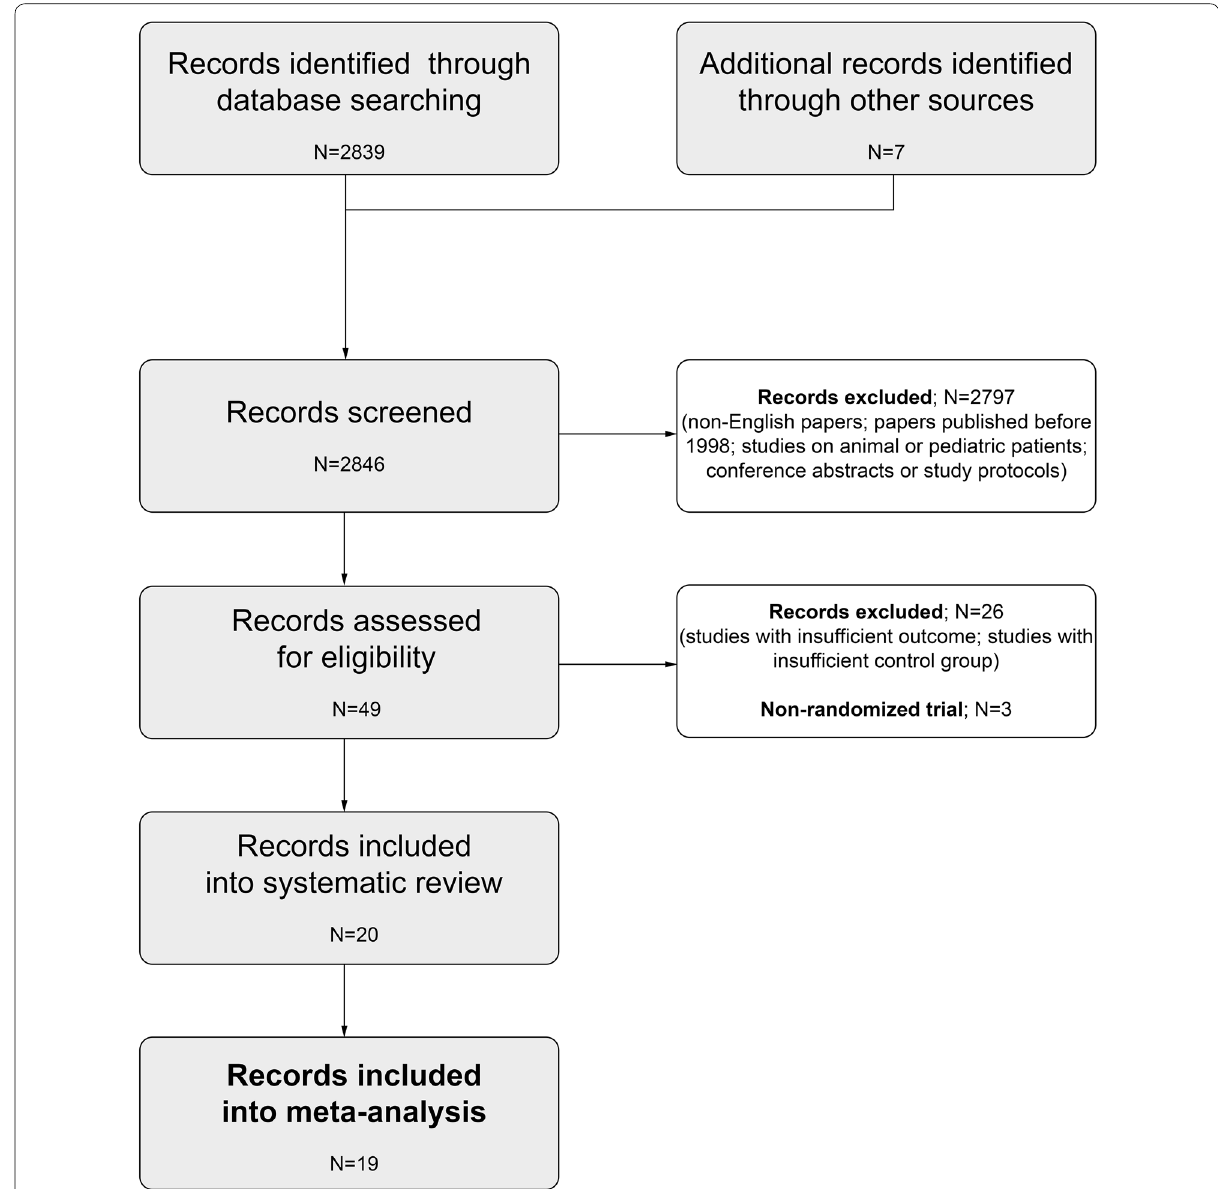
Fig. 1 Flow diagram of the study selection